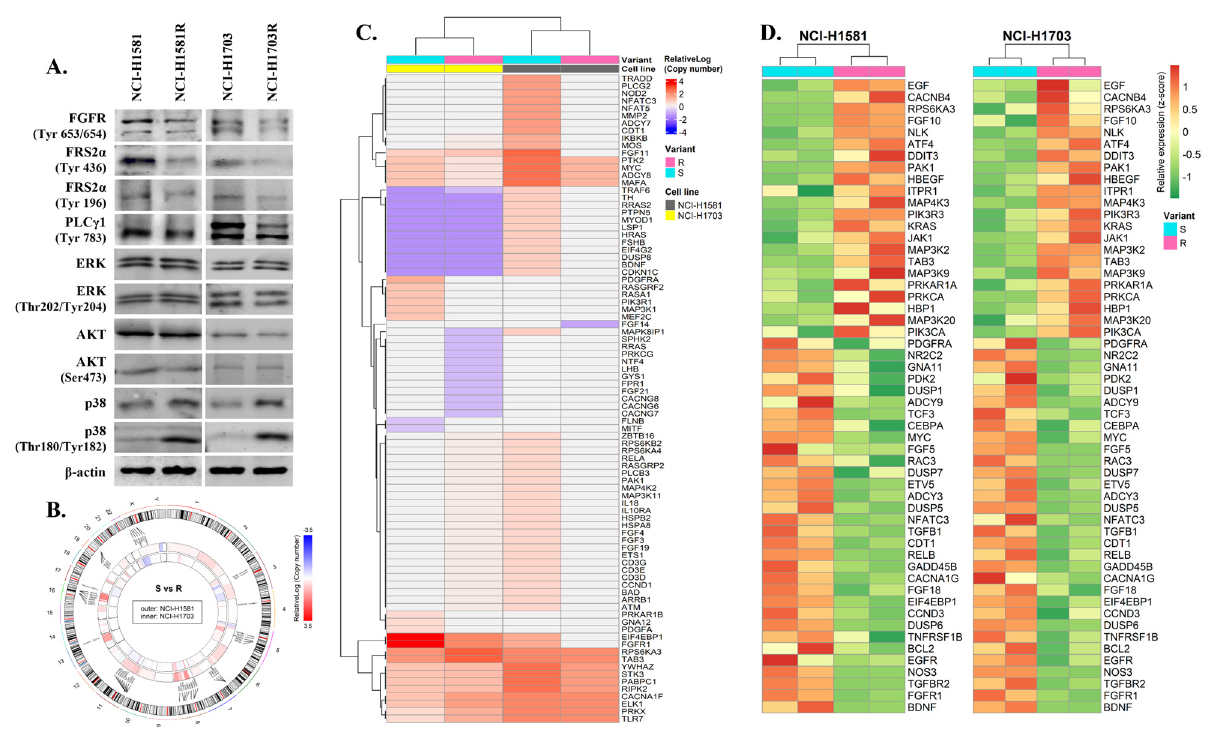
Figure 3. Involvement of p38 kinase in resistance to FGFR inhibition. ( A ) Protein expression/phosphorylation levels of FGFR and its direct downstream effectors were analysed with Western blot. Experiments were conducted in triplicates. Representative blots are shown. ( B ) A circos plot showing a copy number variation (relativeLog) in resistant variant of NCI-H1581 (outer circle) and NCI-H1703 (inner circle) cell lines in comparison to respective sensitive variant. Enlarged circos plot with a legible gene names is shown in Supplementary Materials. ( C ) A heat map showing genes with copy number variation (CNV) between sensitive versus resistant variant (data subjected to rlog transformation). ( D ) A heat map showing differentially expressed genes between sensitive versus resistant cell line variants (only genes with the mutual direction of change in both analysed cell lines are shown; data subjected to rlog transformation).